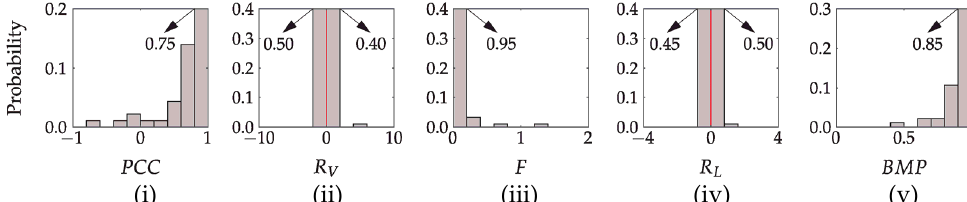
Figure 6. Probability distribution of movement parameters: ( i ) the linear correlation coefficient PCC , ( ii ) the ratio of variances R V , ( iii ) the Fréchet distance F , ( iv ) the ratio of hand path lengths R L , and ( v ) the upper limb bimanual movement parameter BMP of a healthy subject for the activities shown in Figure 5. The red vertical line marks the boundary between the dominant and non-dominant upper limb. The arrows indicate the peak values in each plot.